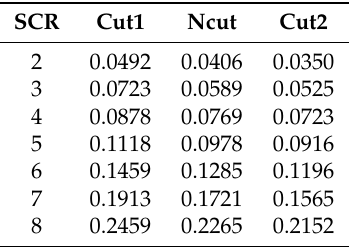
Table 4. Commutation failure immunity index (CFII) under di ff erent operations.